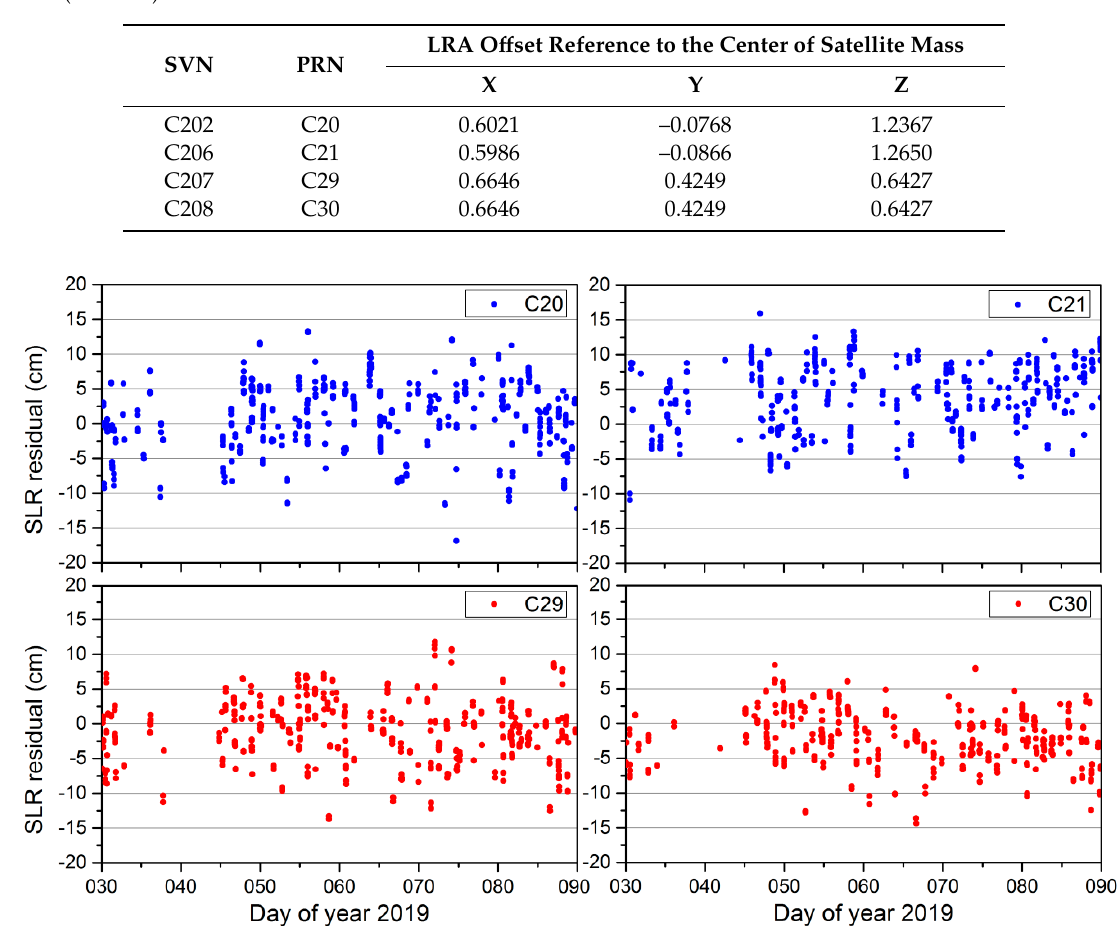
Figure 9. The satellite laser ranging (SLR) validation residuals of the BD3 MEO satellites, where C20 / C21 are made by CAST and C29 / C30 are made by